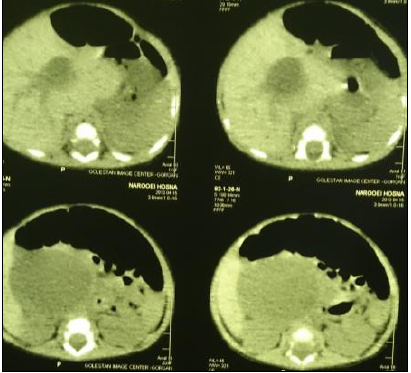
Figure 1: Cyst at